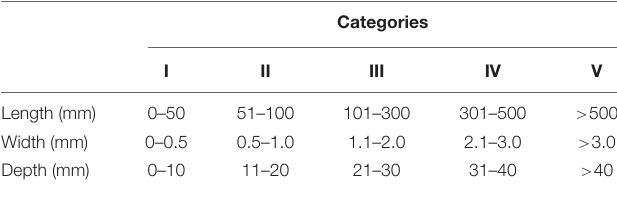
TABLE 1 | Check categories based on check length, width, and depth.